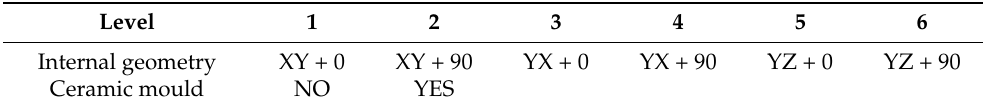
Table 2. Variables and levels.